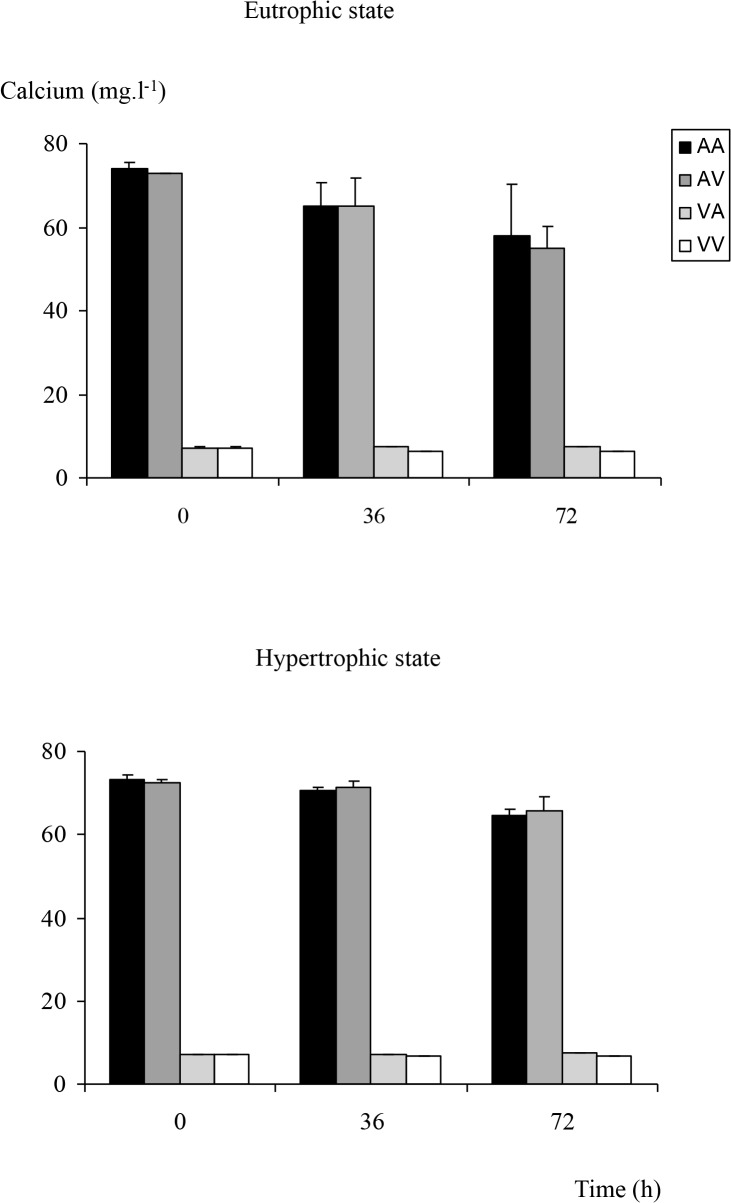
Dynamics of water calcium.Dynamics of calcium (in mg.l−1) contained in Alsatian or Vosgian water for eutrophic and hypertrophic conditions and for all the possible combinations of water and subpopulation. In the legend, AA, AV, VA, VV include the information on the treatment, the first letter refers to the type of water and the second one to the subpopulation (e.g. AV means Alsatian water and Vosgian subpopulation).